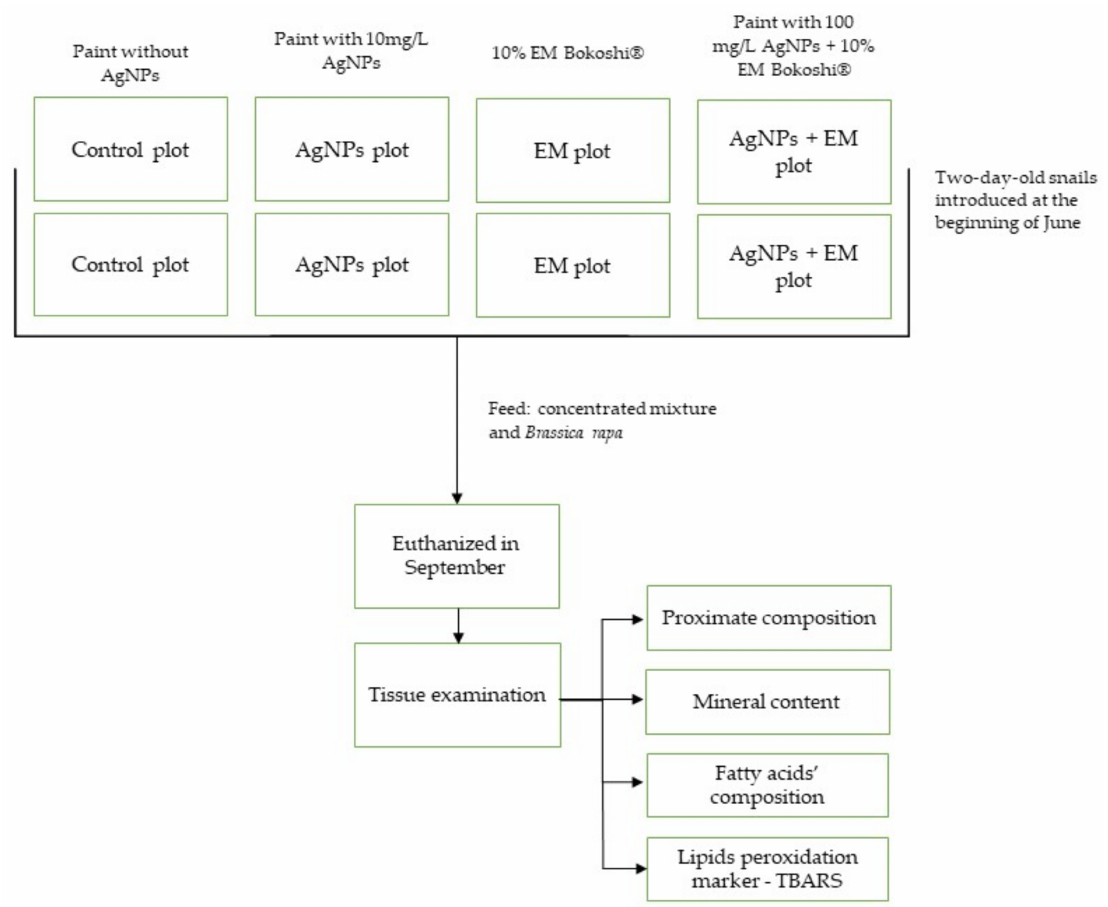
Figure 2. Experiment